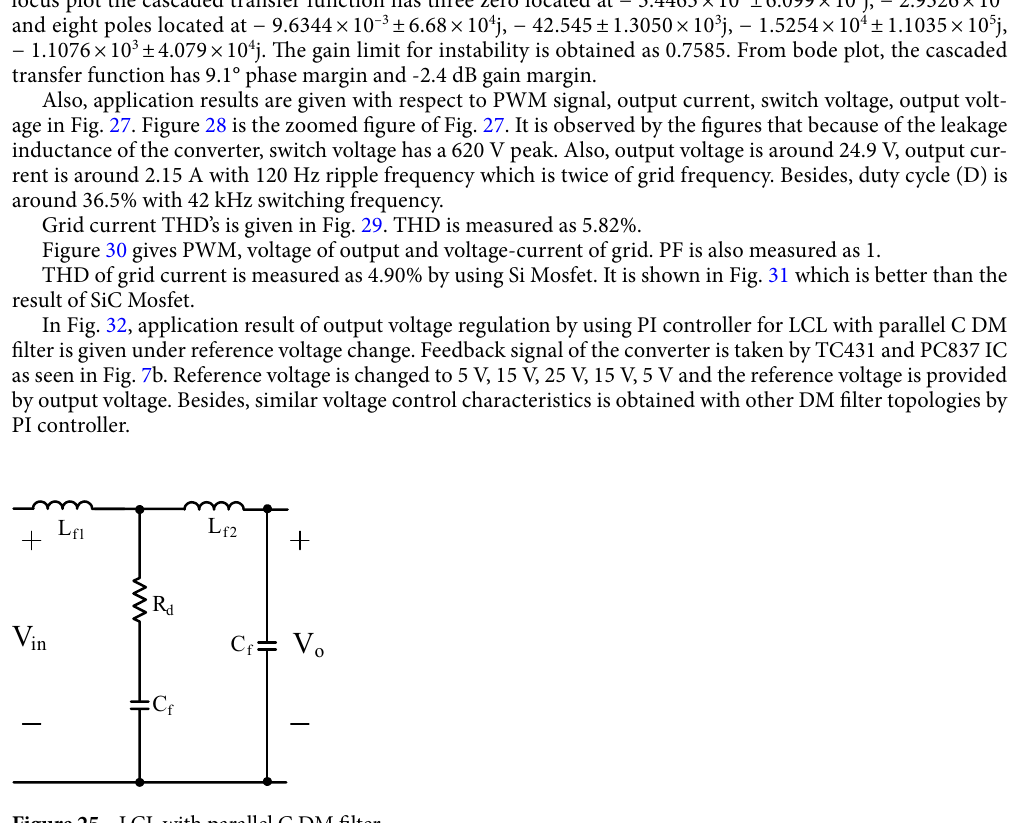
Figure 25. LCL with parallel C DM